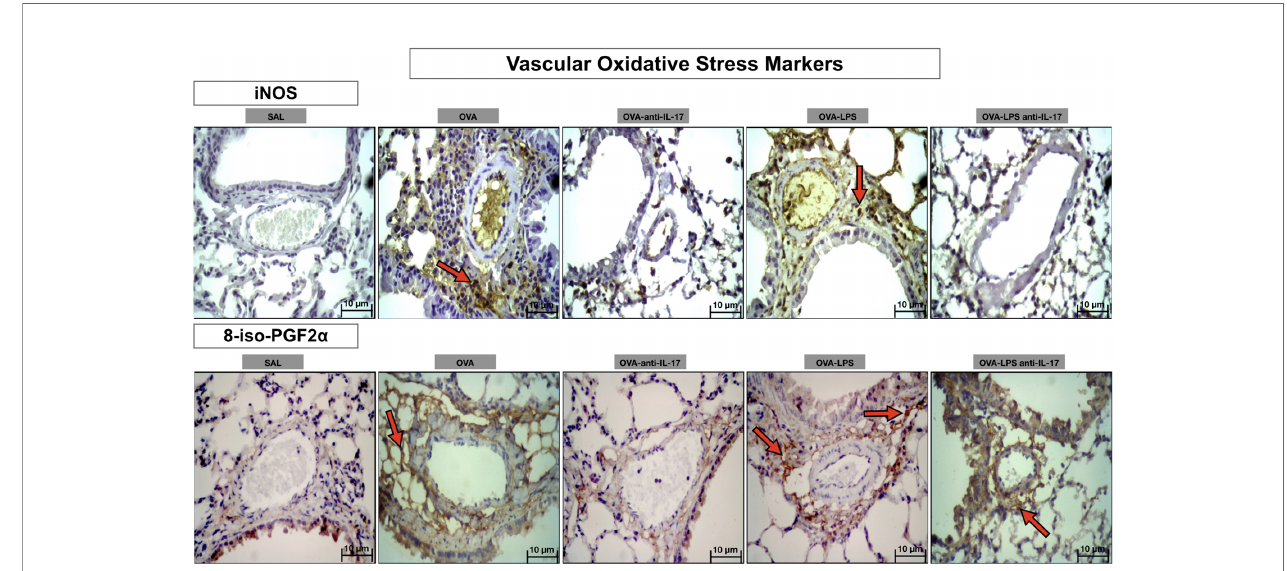
FIGURE 12 | Qualitative analysis of vascular stress oxidative. Photomicrographs showing the presence of in fl ammation around the pulmonary vessels. The slides were stained for iNOS expressing positive cells and isoprostane content. The experimental groups include SAL, OVA, OVA-anti-IL-17, OVA – LPS, and OVA – LPS-anti- IL-17. The red arrows indicate the positive cells for iNOS and isoprostane